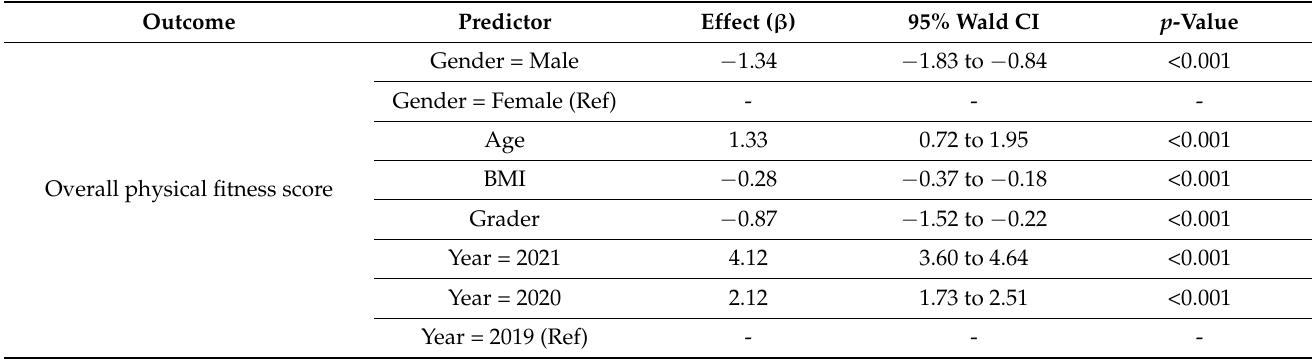
Table 3. Effect estimates on the outcome measures by year and covariates, including gender, age, and BMI using